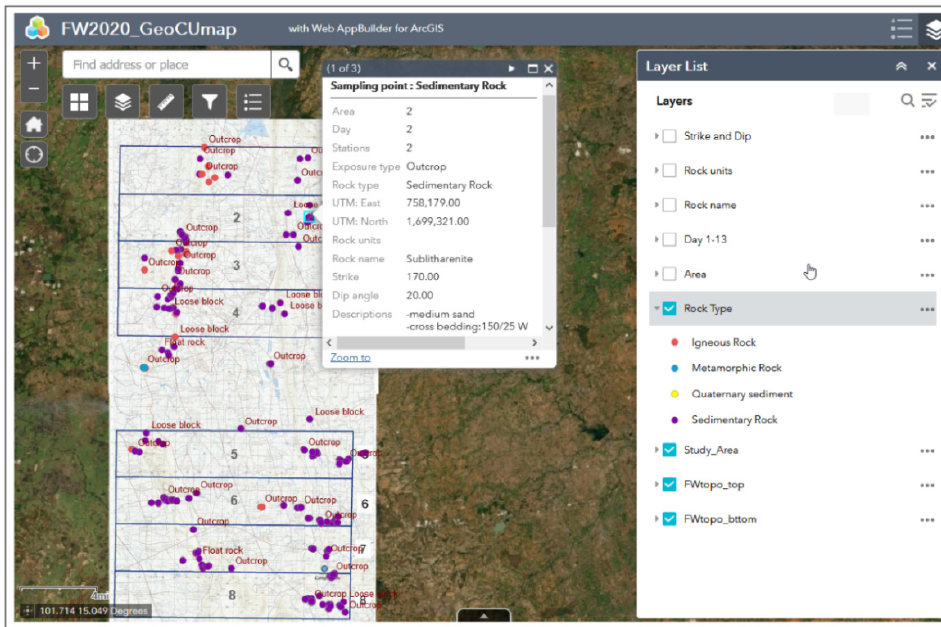
Figure 4. The interface of the web map application in ArcGIS Online on PC and tablet. On the PC and tablet versions, the separate layer list panel and pop-up window panel make the online map more convenient to use because it can show a legend, sampling point information, and a map all at once. Georeferenced maps of any kind can be imported as layers and shown on a smart device.